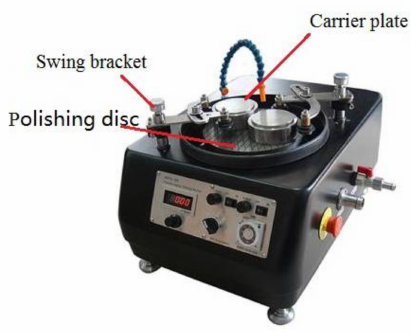
Figure 6. Precision auto lapping and polishing machine.